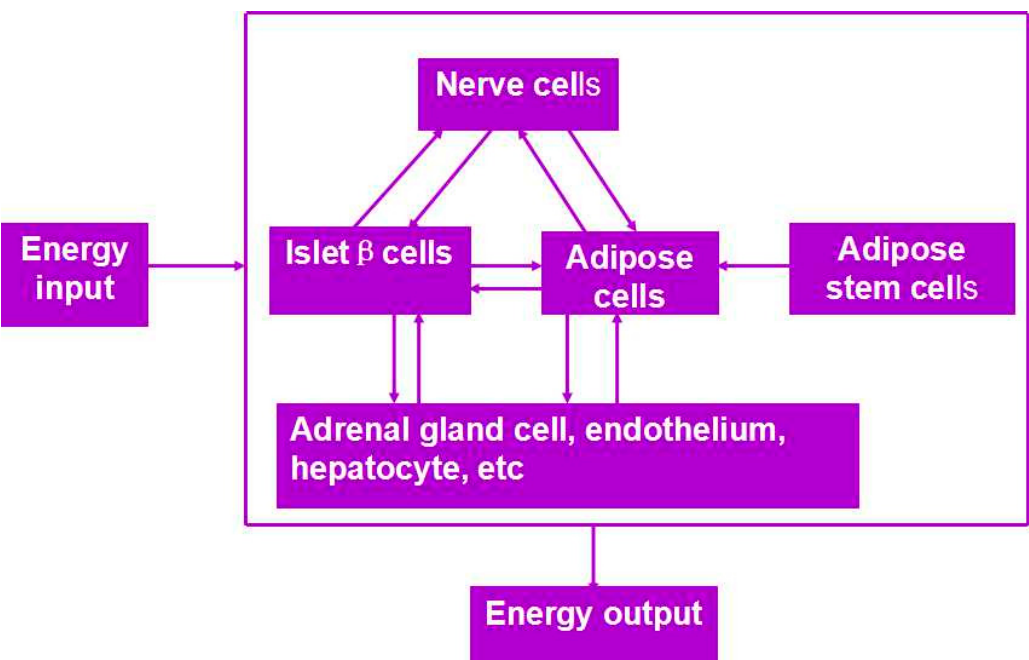
Figure 4. An energy metabolism model established through the adipose-derived stem cell (ADSC) laden gelatin-based hydorgel double-nozzle 3D bioprinting technology.